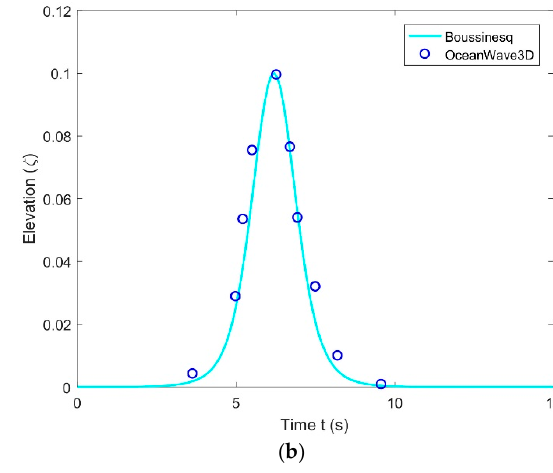
Figure 5. Comparisons of the solitary waveform in the outer region against CFD model simulations for different nonlinear quantities with ( a ) Comparison for ε = 0.1, ( b ) Comparison for ε = 0.3, ( c ) Comparison for ε = 0.5, and ( d ) Comparison: analytical, CFD, and external numerical model [31] (see [31]) versus time t (s).